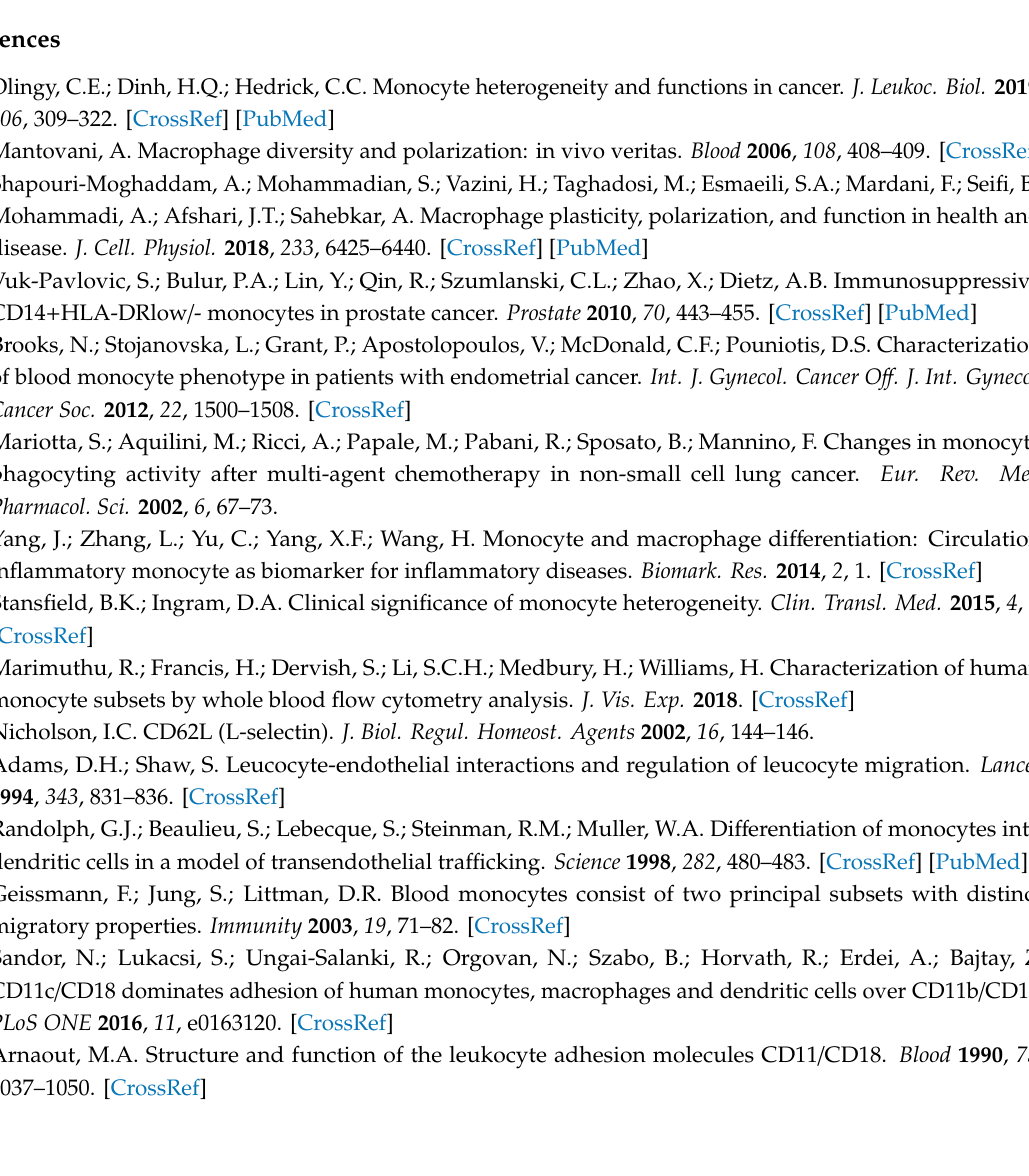
Figure S1: Flow cytometry analysis of alveolar macrophage (AMs) in hlBALF (A) and clBALF (B), Figure S2: The gating strategy of monocytes and CD11c expression histograms with statistic in PB from representative cancer patient, Figure S3: The gating strategy of monocytes and CD18 expression histograms with statistic in PB from representative cancer patient, Figure S4: The gating strategy of monocytes and HLA-DR expression histograms with statistic in PB from representative cancer patient, Figure S5: The gating strategy of monocytes and CD62L expression histograms with statistic in PB from representative cancer